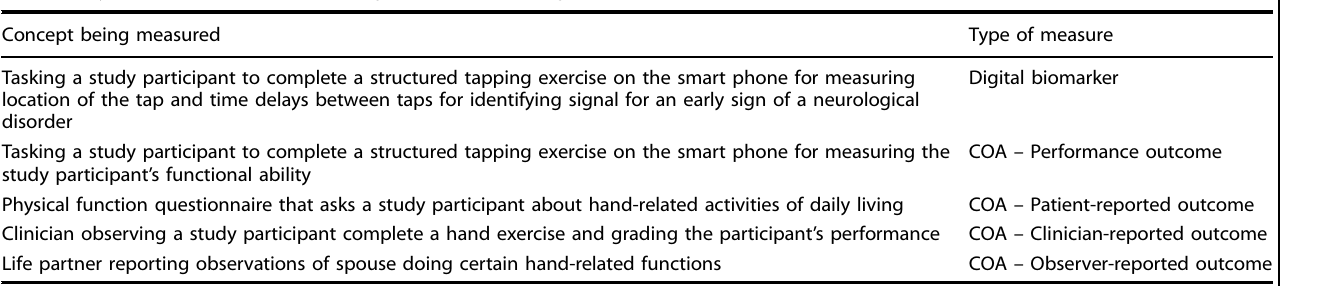
Table 2. Hypothetical example of assessing hand function using a smart phone a . Concept being